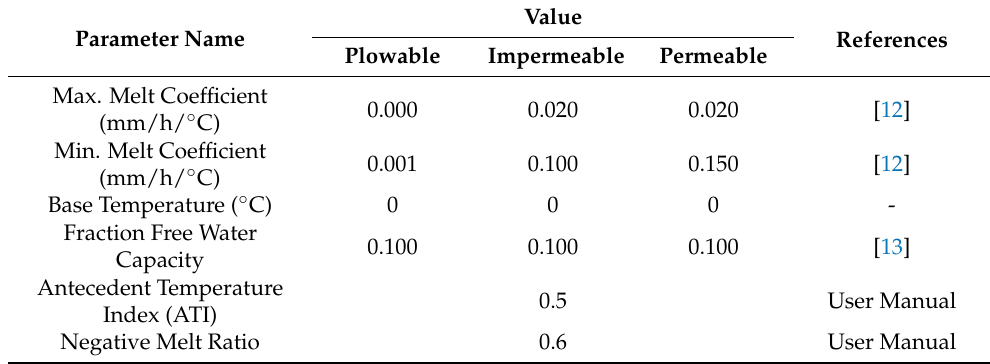
Table 5. Snowmelt